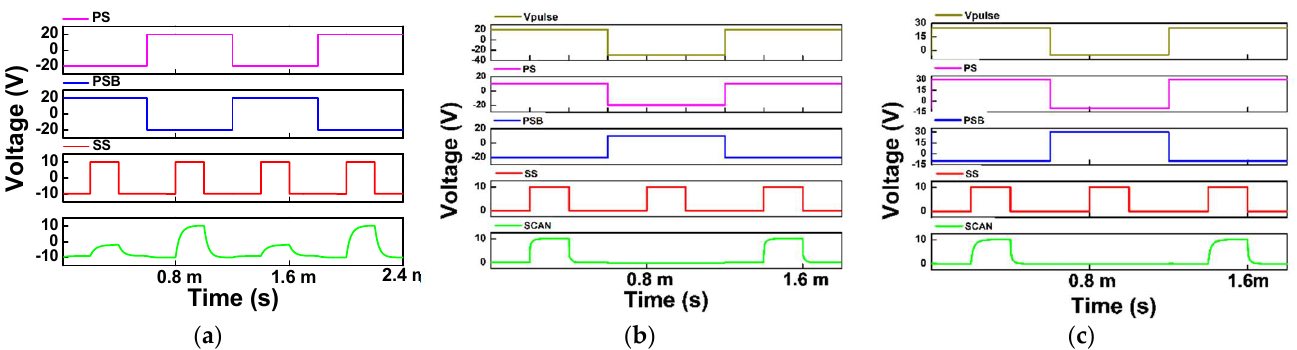
Figure 8. ( a ) Simulated waveforms for unit-stage bootstrap circuit using depletion-mode TFT; ( b ) simulated waveforms for the unit-stage modified bootstrap circuit using depletion-mode TFT; ( c ) simulated waveforms for unit-stage modified bootstrap circuit using enhancement-mode TFT.